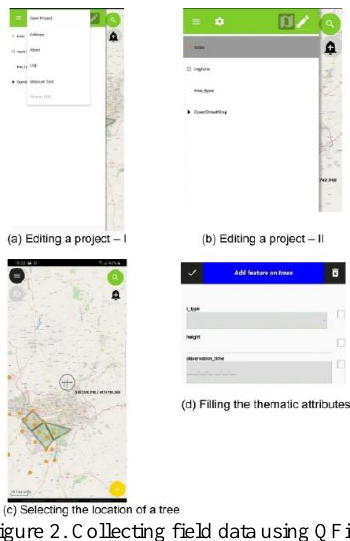
Figure 2. Collecting field data using QField